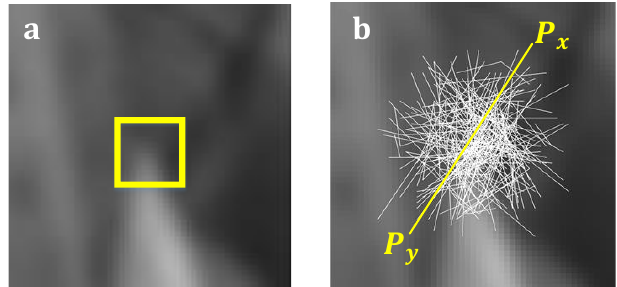
Figure 8. ( a ) A feature point on image; ( b ) Put a patch on feature point.